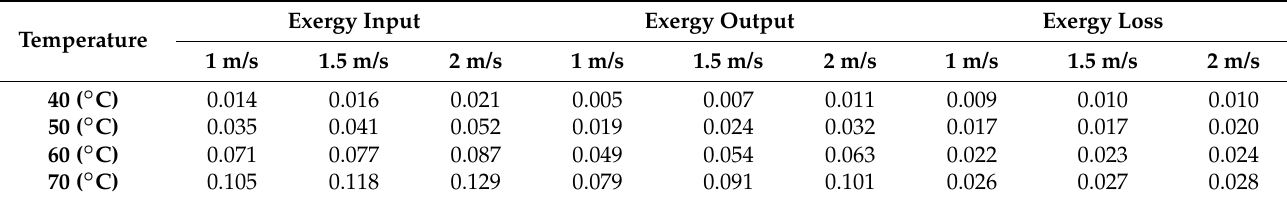
Table 3. The results of exergy analysis (kJ/s) for the drying process of rosemary